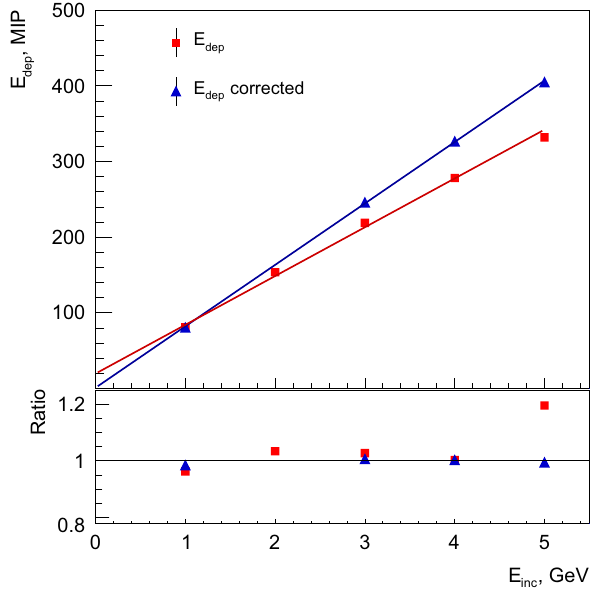
Fig. 13 Distribution of the deposited energy in a sensor pad in the detector layer after 5 tungsten plates. The red line is a MC simulation, and the black line is data using as calibration an interpolation between measured calibration values of the APV25 front-end chip. The sharp spikes are due to saturation in two APV25 front-end boards